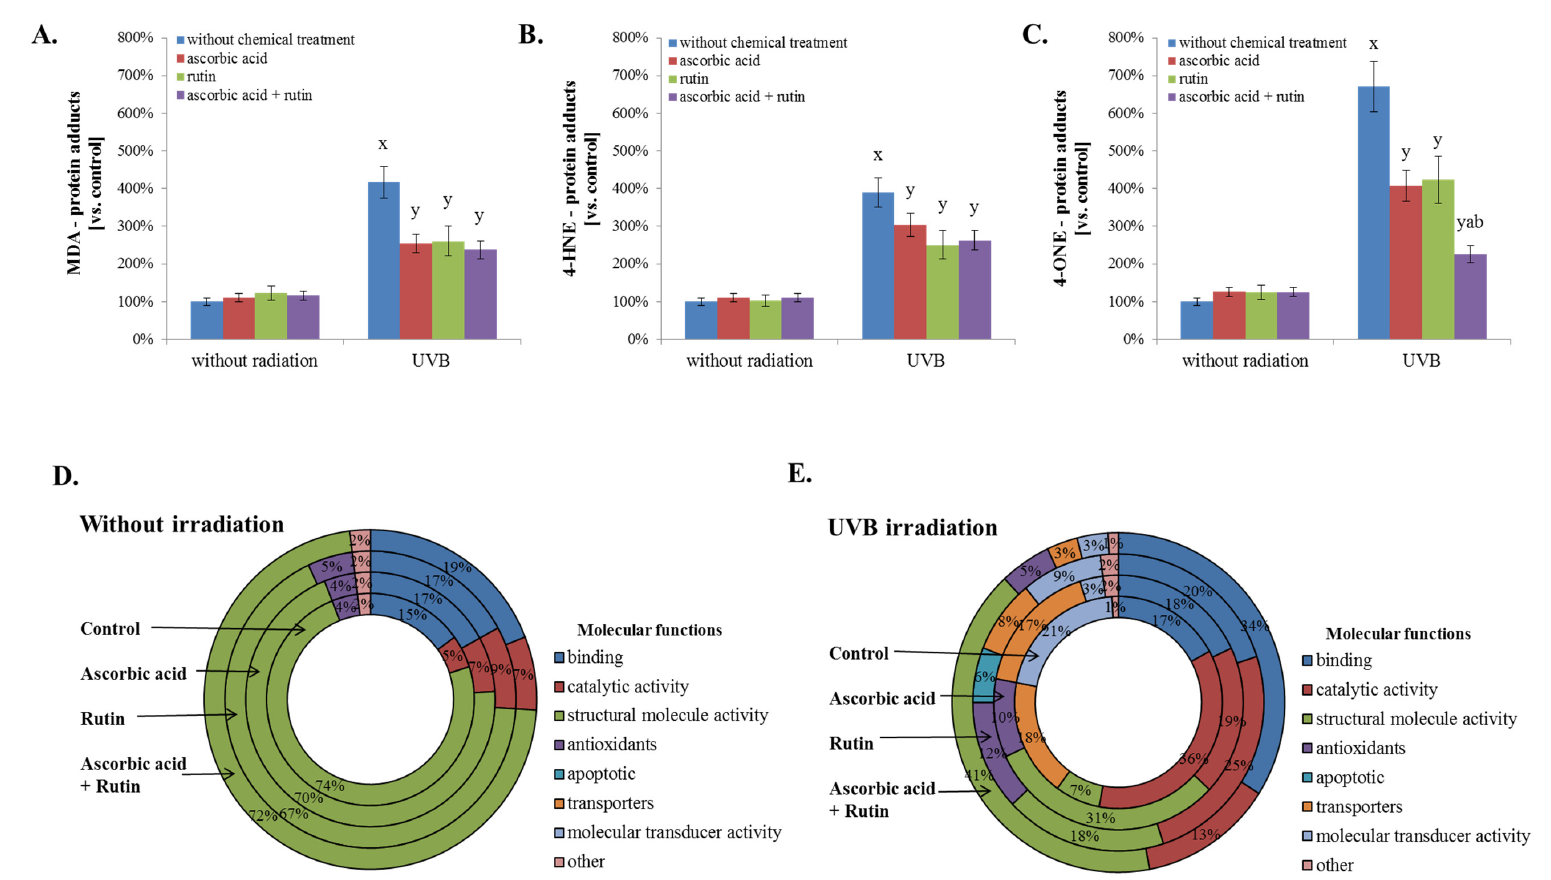
Figure 4. The level of protein adducts with selected lipid peroxidation products, such as malondialdehyde (MDA) ( A ), 4-hydroxynonenal (4-HNE) ( B ), and 4-oxynonenal (4-ONE) ( C ); the molecular functions of these proteins in 3D cultured fibroblasts were treated with rutin [25 μ M] and/or ascorbic acid [100 μ M] ( D ), and exposed to UVB irradiation (200 mJ/cm 2 ) ( E ). Analysis made based on data from the Panther Classification System. Mean values ± SD of three independent experiments are presented. x statistically significant differences vs. non-treated group, p < 0.05; y statistically significant differences vs. group without chemical treatment, p < 0.05; a statistically significant differences vs. ascorbic acid treated group, p < 0.05; b statistically significant differences vs. rutin treated group, p < 0.05.